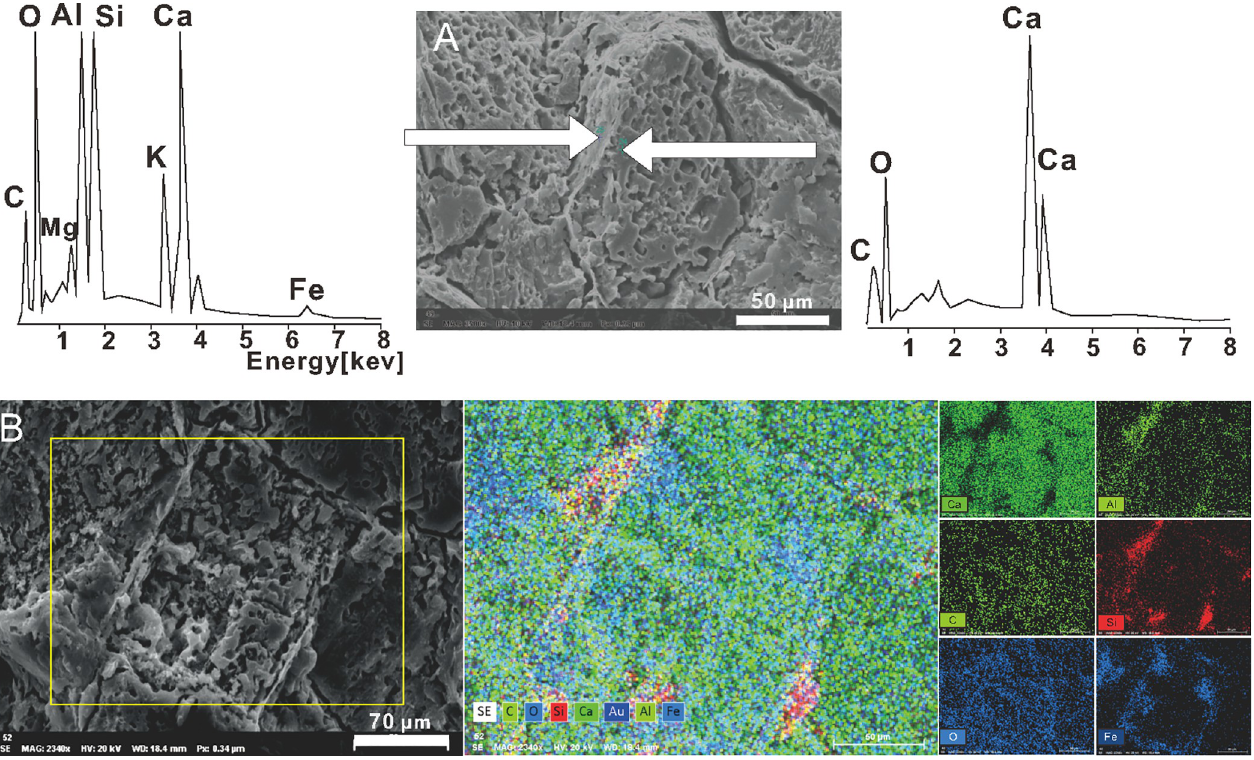
Fig 6. EDS spectra of mineralized spherical capsule (A, spot analyses) and rectangular capsule (B, panel analyses). Scale bars: A– 50 μ m; B– 70 μ m.